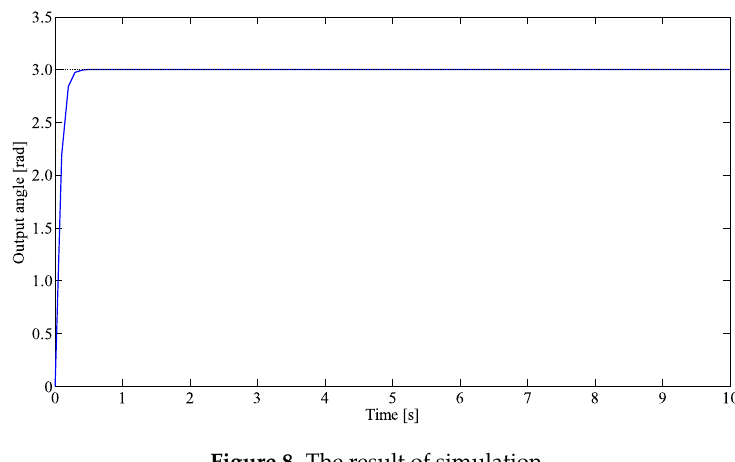
Figure 8. The result of simulation.